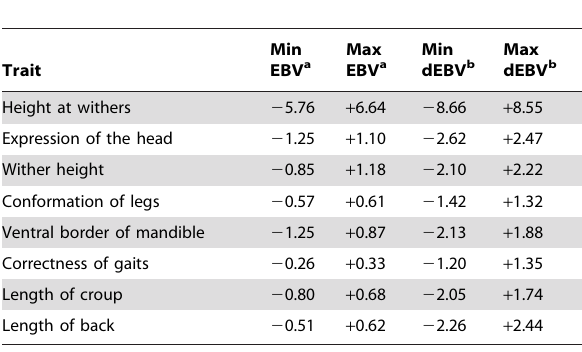
Table 1. Distribution of EBVs and dEBVs for conformation traits in FM horses.